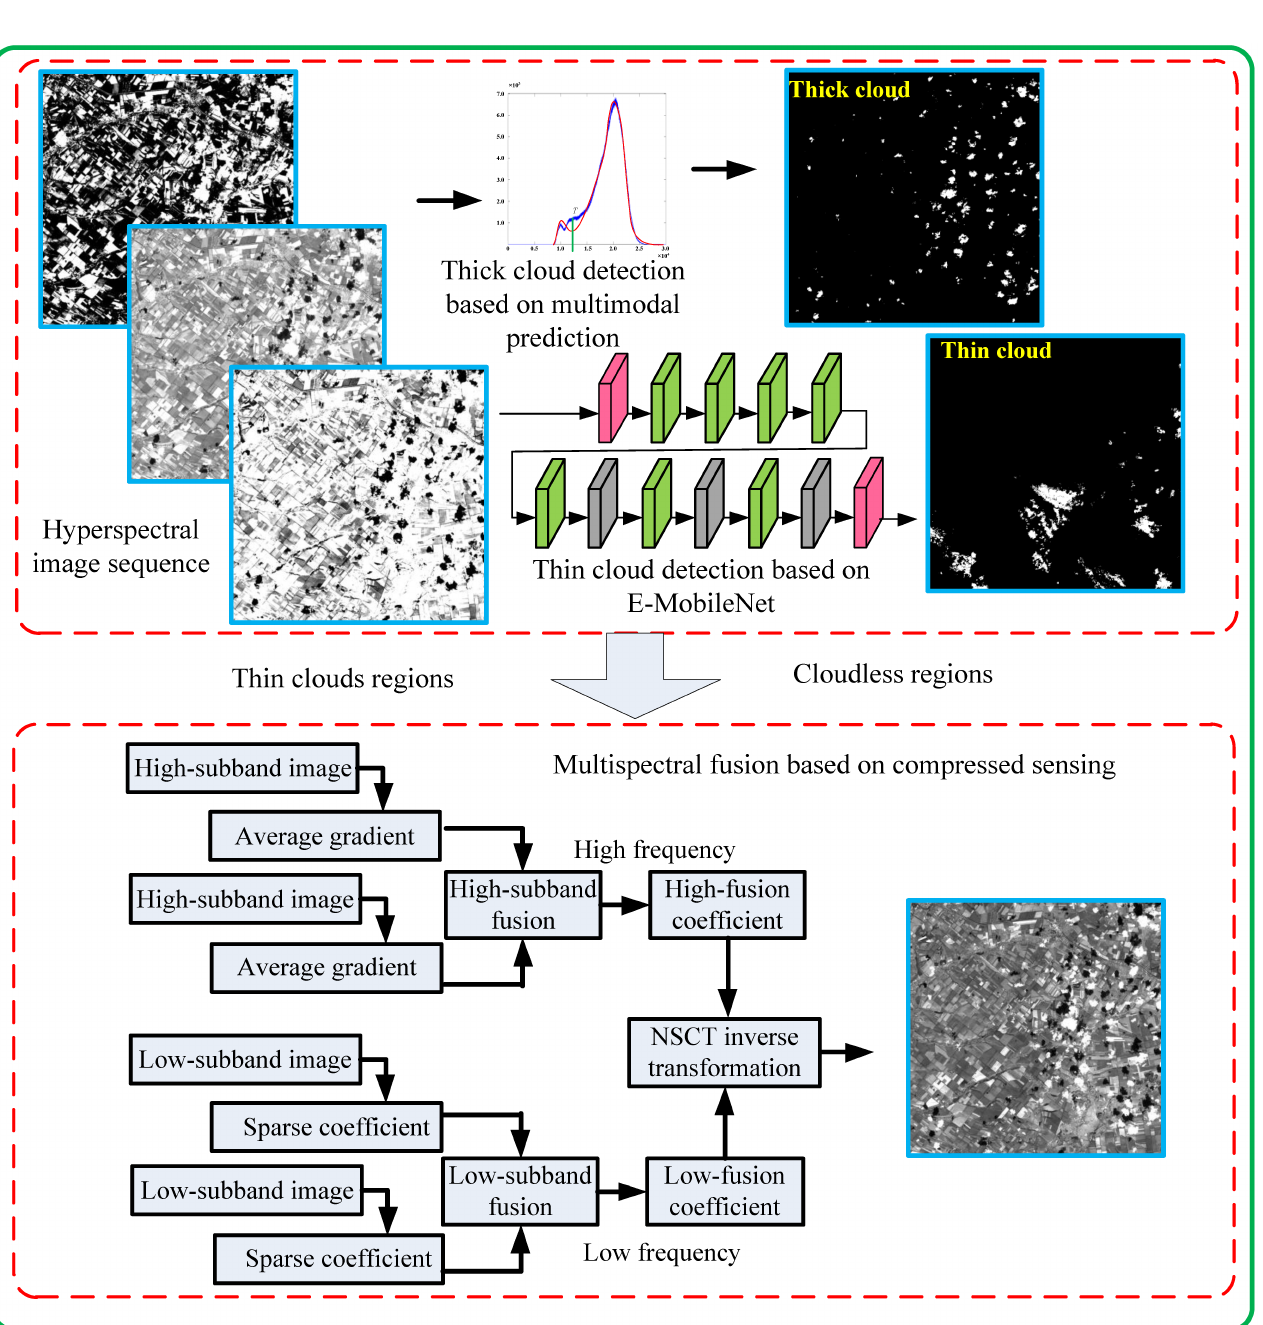
Figure 1. Flowchart of the proposed